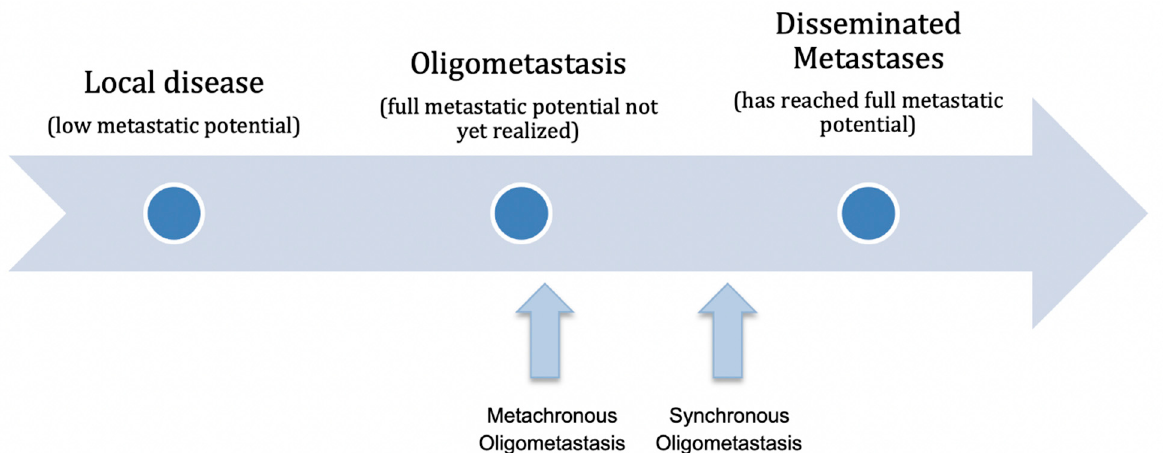
Figure 1. Oligometastasis represents an intermediate disease state along a continuum of malignant potential of the primary tumor and its metastases, as previously described by Hellman and Weichselbaum [1,11].